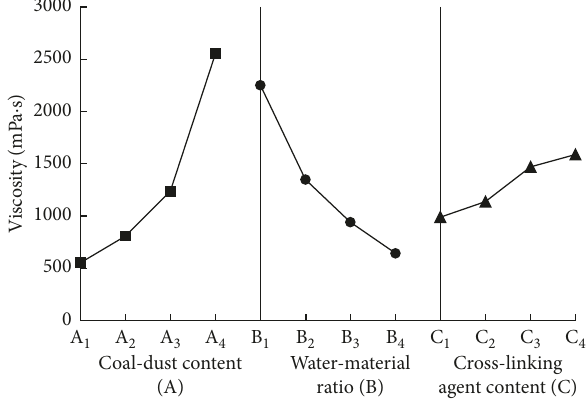
Figure 2: Effective curves of the factors affecting